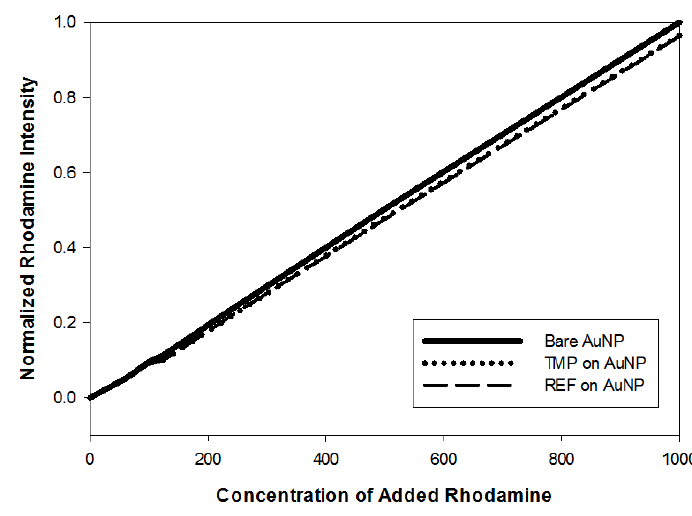
Figure 5. TMP and REF (0.035 g/L) stabilized on to multiple 20 nm AuNP samples then added to varying concentrations of rhodamine-B (10–1000 nM) aliquots. The various solutions were all heated to the corresponding LCST then spun down and the supernatant was removed and analyzed for remaining unbound rhodamine-B. Binding Kinetics: Because our copolymer has fewer crosslinks and more flexibility than typical templated polymers, we expected it to react more rapidly. This was tested by combining equal volumes of a fluorescein solution and a suspension of copolymer coated AuNPs in a stirred fluorescent cuvette and measuring intensity vs. time at 40 °C. The results of this experiment are summarized in Figure 6. When fluorescein solution is mixed with deionized water or with REF coated AuNPs, the observed intensity decreases by ca. 50% as expected for dilution. When fluorescein solution is combined with TMP coated particles, the intensity decrease is larger and it takes longer for the intensity to reach a constant value. We attribute the extra decrease in intensity to concentration quenching because binding will bring fluorescein molecules into close proximity.